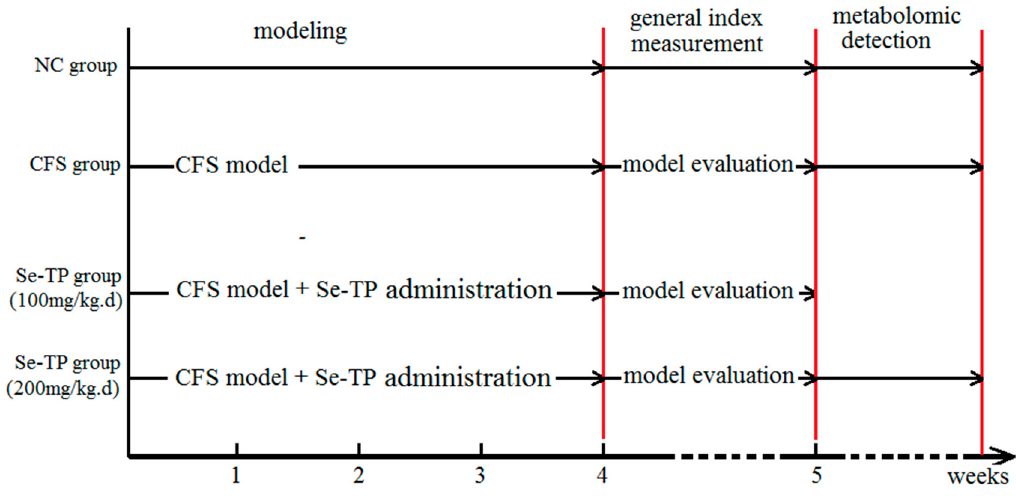
Figure 1. Schedule of experimental design.